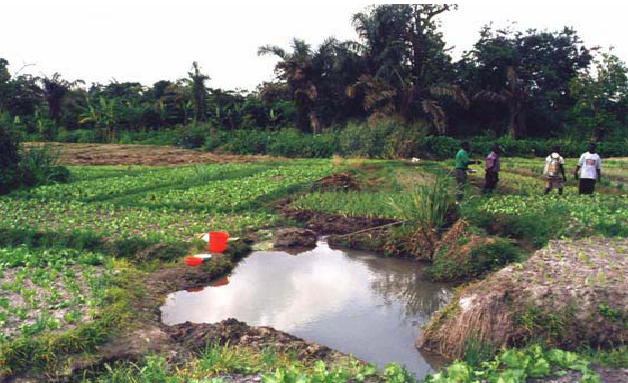
Figure 3. Stagnant water as a result of urban farming (source